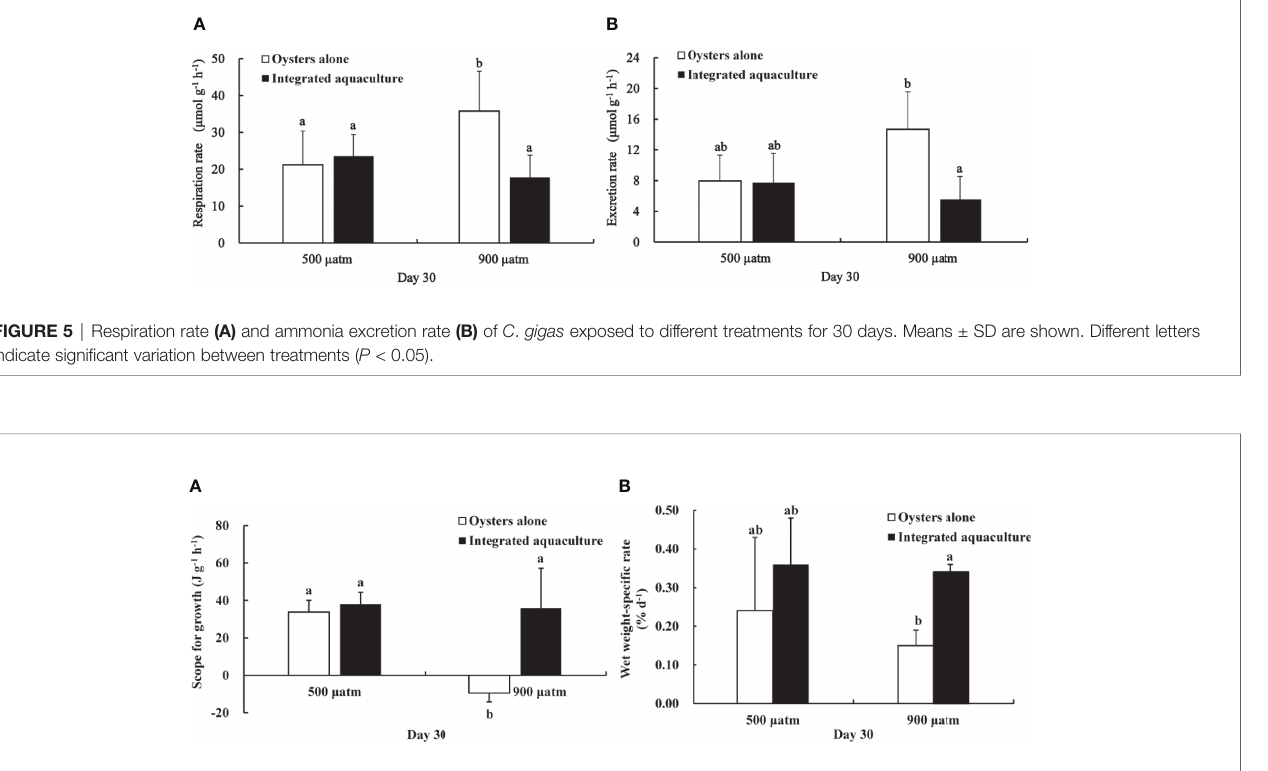
FIGURE 6 | Scope for growth (A) and wet weight-speci fi c rate (B) of C . gigas exposed to different treatments for 30 days. Means ± SD are shown. Different letters indicate signi fi cant variation between treatments ( P < 0.05).